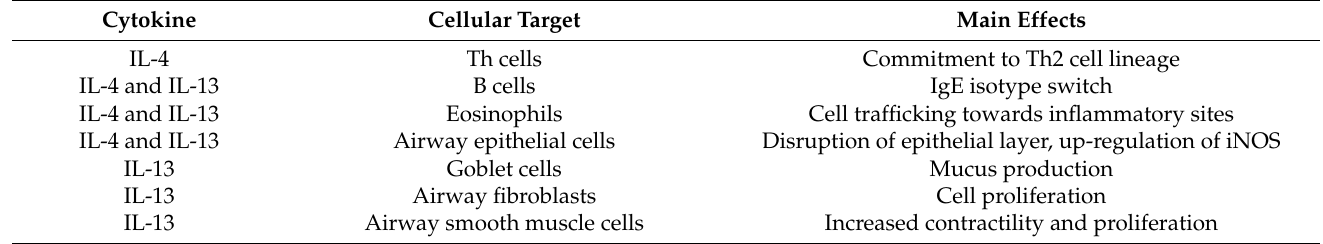
Table 1. Main biological actions exerted by IL-4 and IL-13 within the asthmatic